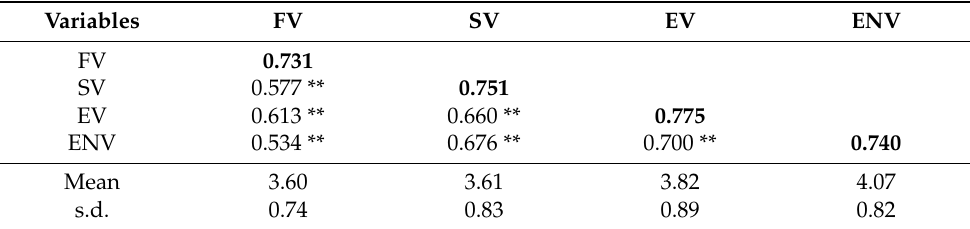
Table 3. Descriptive statistics, correlations between variables, and discriminant validity.